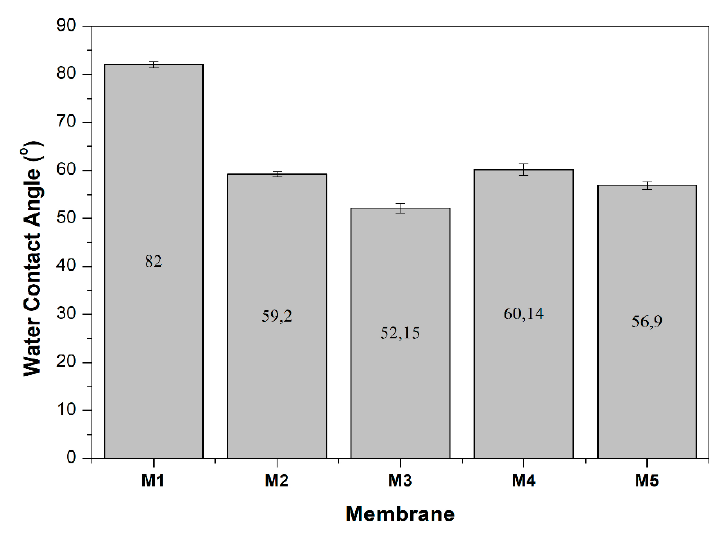
Figure 3. Water contact angle of prepared membranes.